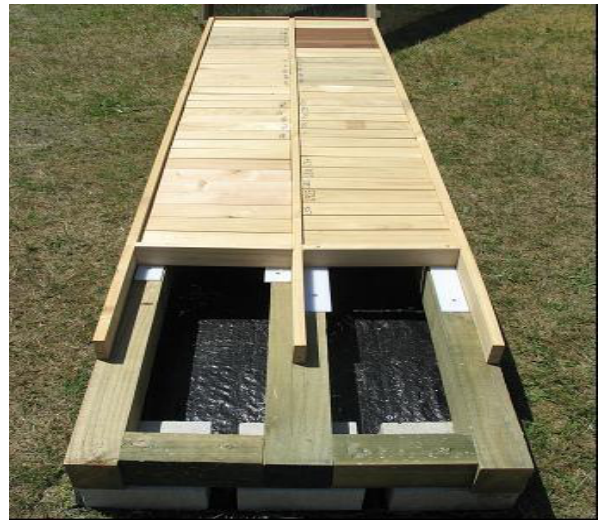
Figure 2. Double layer test at installation. 100 mm square bearers supported on concrete blocks with plastic weed cloth underneath. The plastic strips between the samples and bearers were removed after a few weeks exposure. The batten along the centre was untreated pine, those on the outside were H3 treated. The whole assembly was surrounded by a 300-mm-deep frame covered with shade